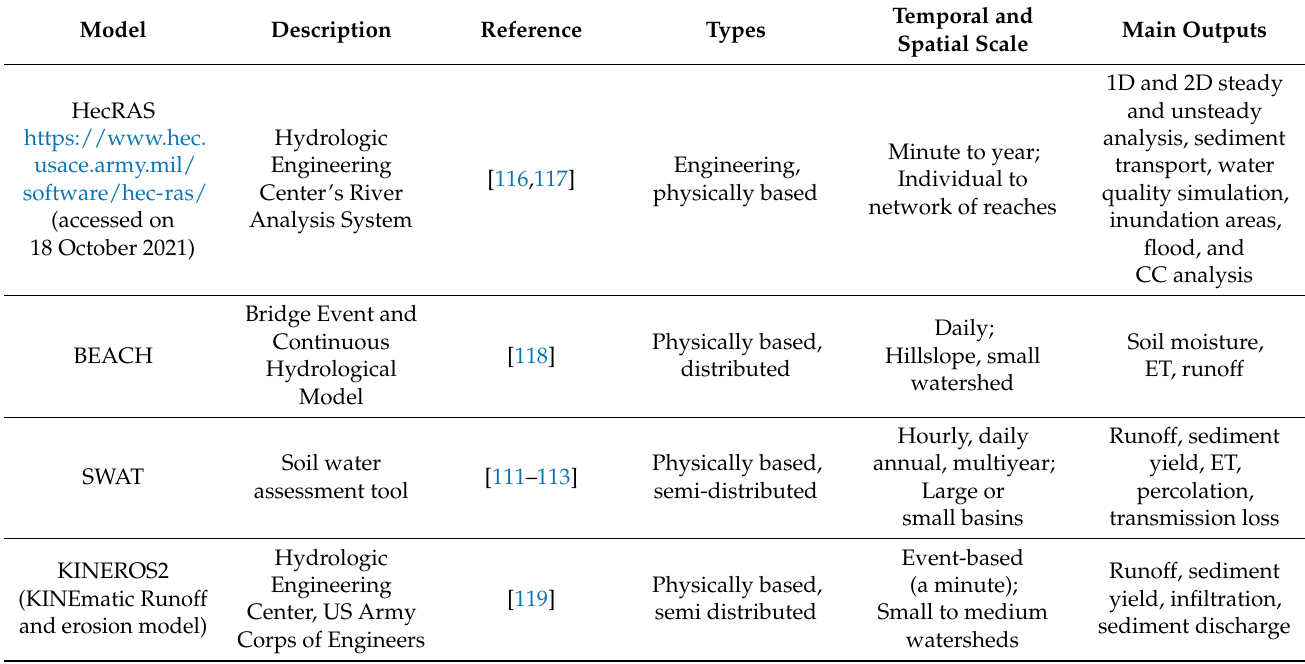
Table 5. List of analytical models used for flood studies in